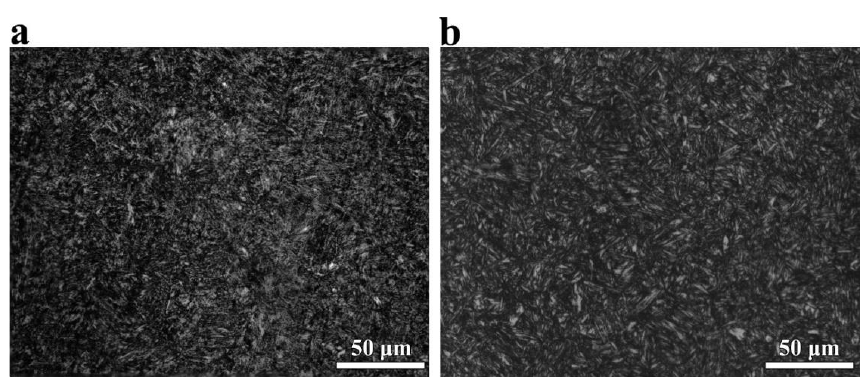
Figure 9. Microstructure of 30CrMnSiA steel. ( a ) Initial state; ( b ) after NA-20000.